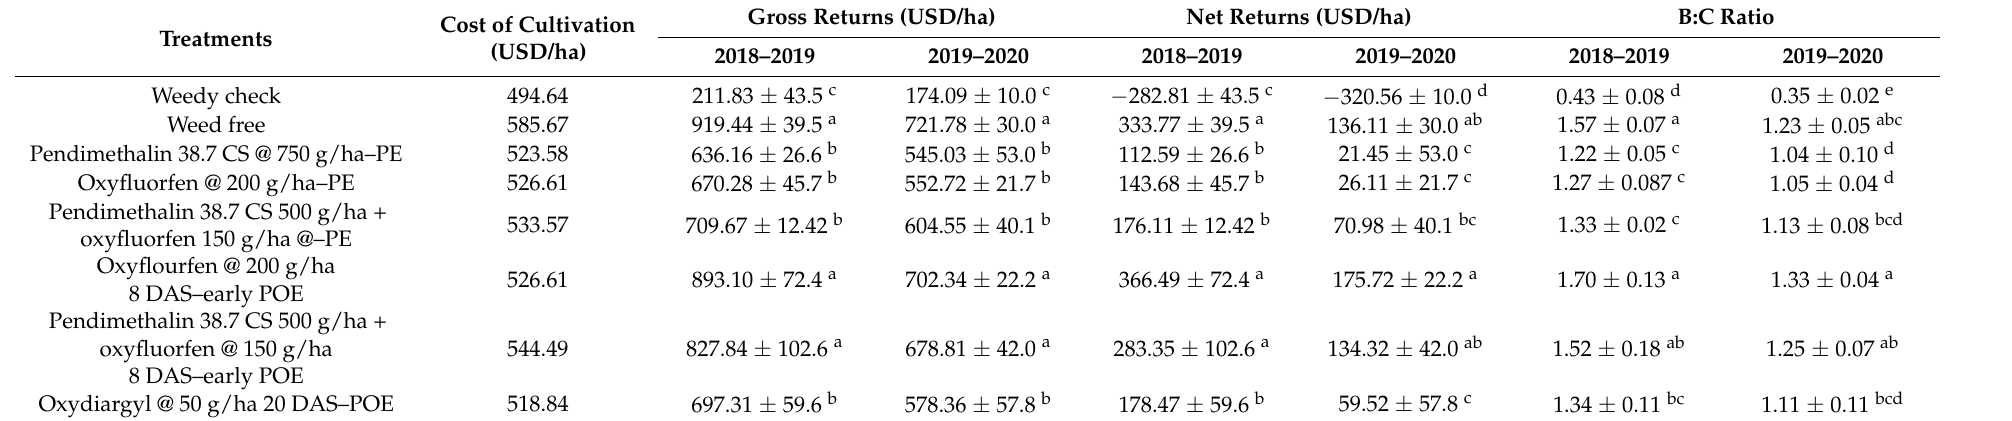
Table 3. Evaluation of economics of different herbicides used for controlling of weeds in